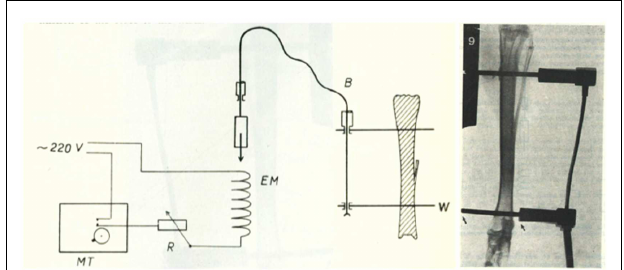
FIGURE 2 |The invasive rabbit loading model . Jiri Hert was the first to describe an artificial mechanical loading model in 1969. Loading was applied through surgically implanted pins in the lapine tibia. Using this approach and assessing the adaptive response of the bone Hert and his co-workers were able to establish, amongst other findings, that adaptive bone (re)modeling occurred without the need for any central nervous connection (42–44).